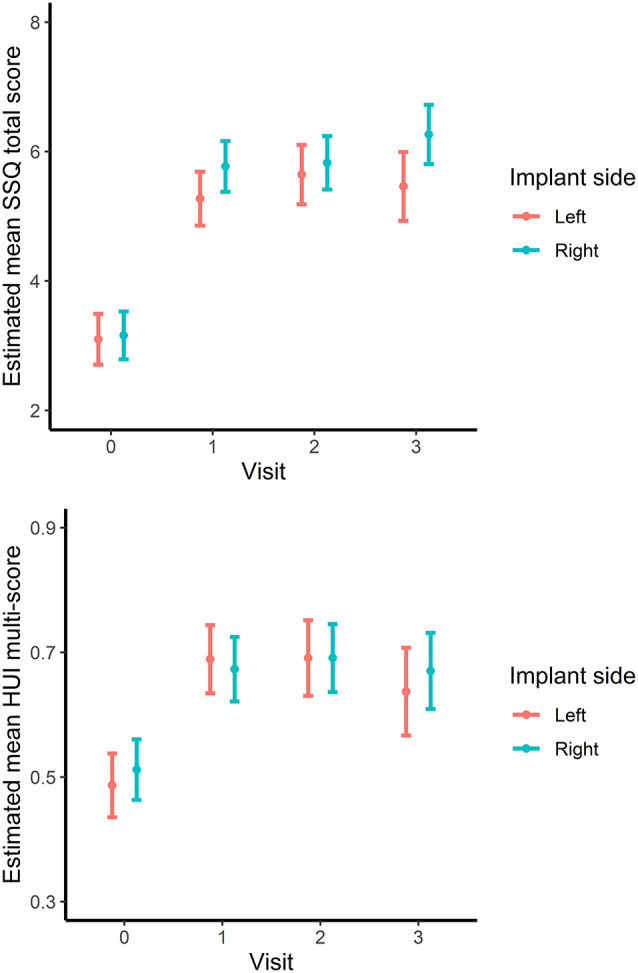
SSQ (upper) and HUI (lower) scores by visit for left- and right-ear implanted subjects. Points and lines indicate least-squares means with 95% confidence intervals.